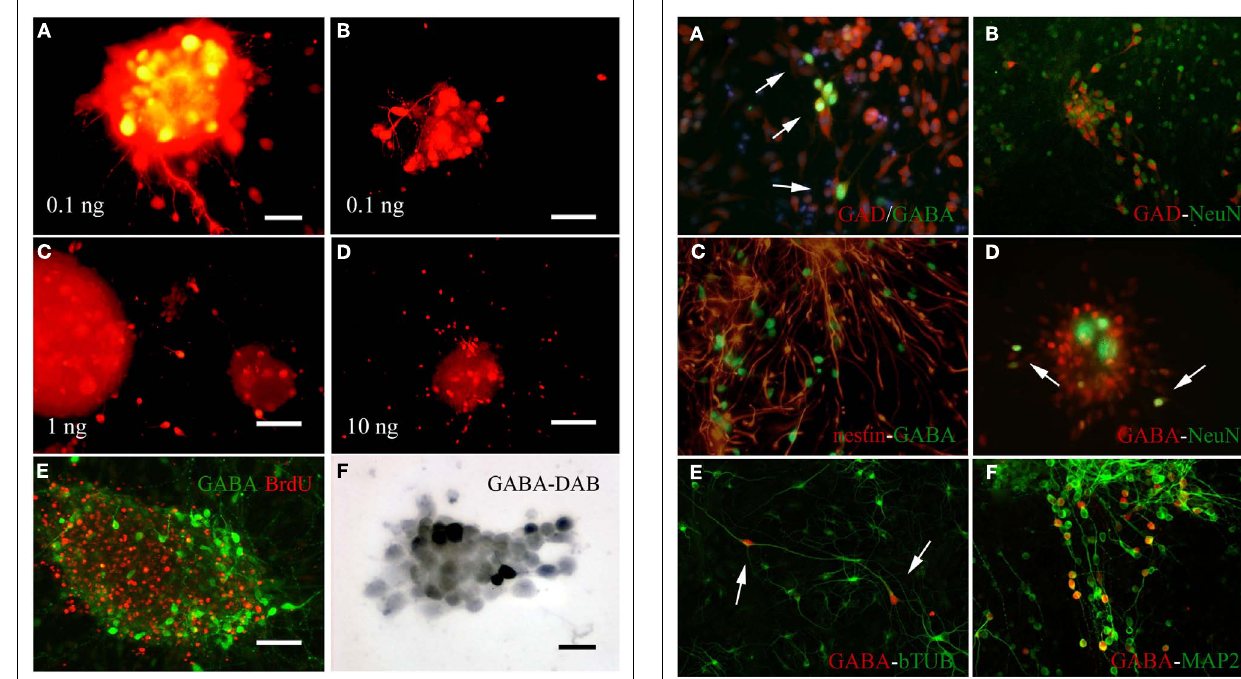
FIGURE 4 | Predifferentiated embryonic precursor neurospheres expressed robust immunoreactivity for GABA and other marker for cell differentiation 5–7 days after harvest. (A) Many of GABA-IR NPCs colocalized with GAD65/67-IR cells (arrows). (B) Majority of predifferentiated GAD65/67-IR NPCs also expressed NeuN-IR. (C) Majority of predifferentiated GABA-IR NPCs also expressed nestin-IR; Not every nestin-IR cells expressed GABA-IR. Many GABA-IR cells colocalized and expressed NeuN-IR (D) , β -III-tubulin-IR (E) , and MAP-2-IR (F) . adrenal fibroblast, n = 7) showed a significant increase in over- grooming area over time where the area at pretransplantation (baseline) was 130.2 ± 28.9 mm 2 and increased by three folds to 348.1 ± 115.08 mm 2 at1 weekpost-transplantation(